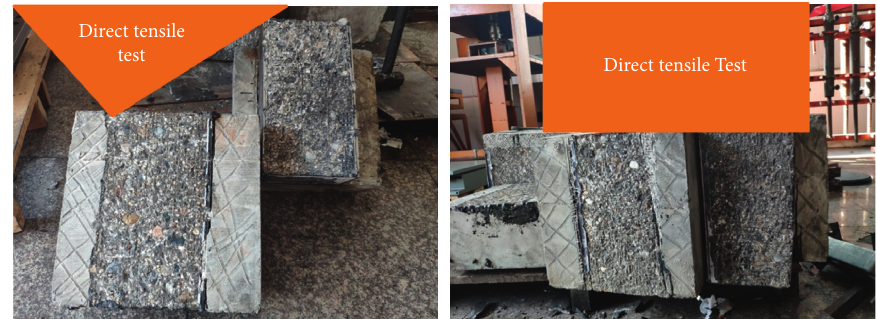
Figure 4: The failure mode of the direct tensile test specimen.